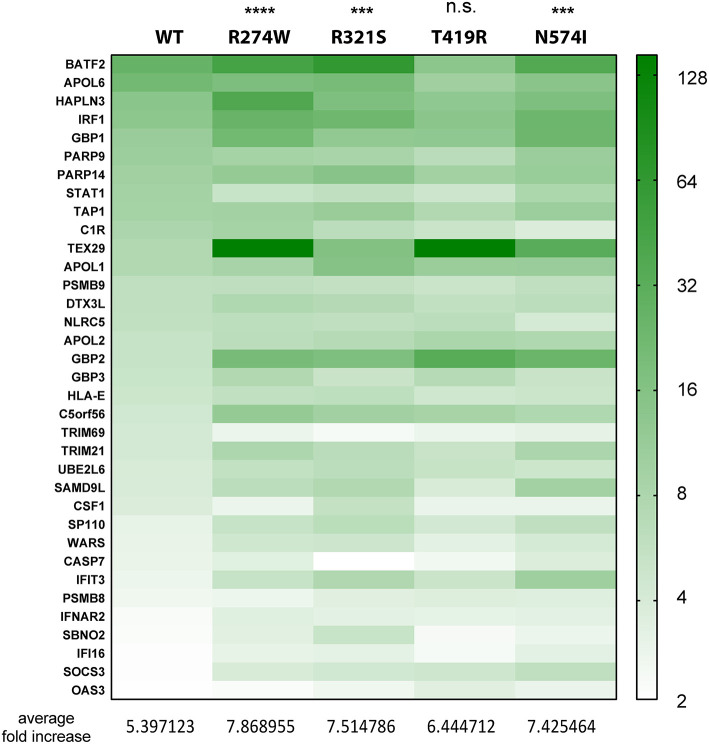
Heatmap indicating the expression level of genes commonly up-regulated in STAT1 WT and all GOF conditions, after IFNγ stimulation, presented in the green part in Figure 2D. Expression level is represented as fold increase compared to unstimulated condition as different shades of green (see scale bar at the right-hand side of the figure). Below the heatmap, the average fold expression increases are reported for the respective column. Statistical analysis indicated on top: Two-way ANOVA with Dunnett's multiple comparison test compared to WT stimulated condition: n.s. not significant; ***p < 0.001; ****p < 0.0001.